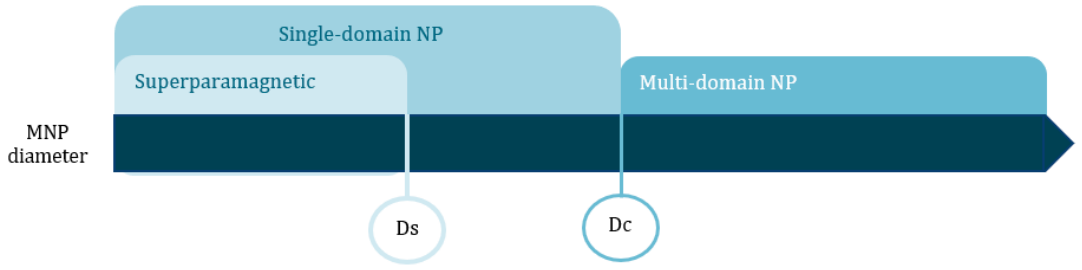
Figure 1. Correlation between MNP (magnetic nanoparticle) size and magnetic domain. Key: Ds stands for superparamagnetism diameter threshold and Dc stands for critical diameter threshold. Table 1. Superparamagnetism (Ds) and critical (Dc) size thresholds for MNPs.